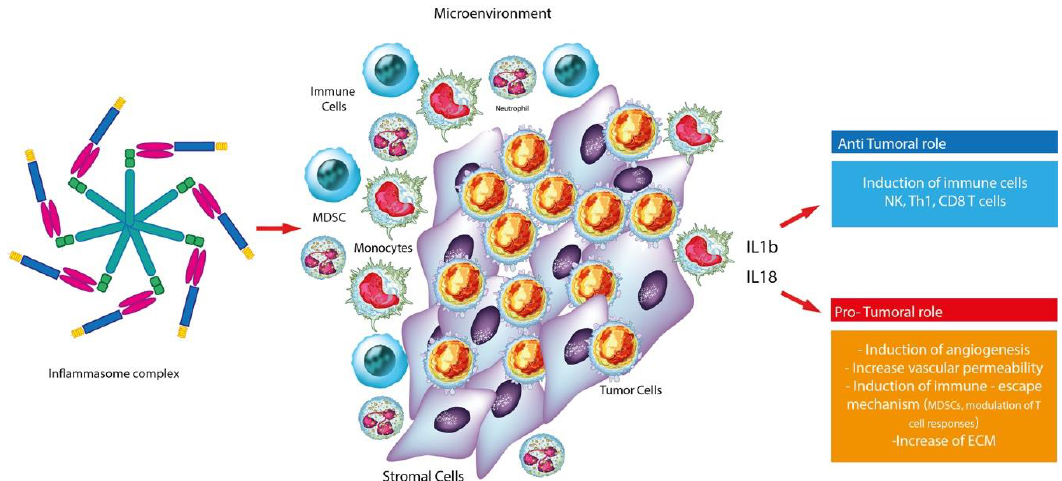
Figure 2. Graphic representation of the dual role of the inflammasome complex in cancer.